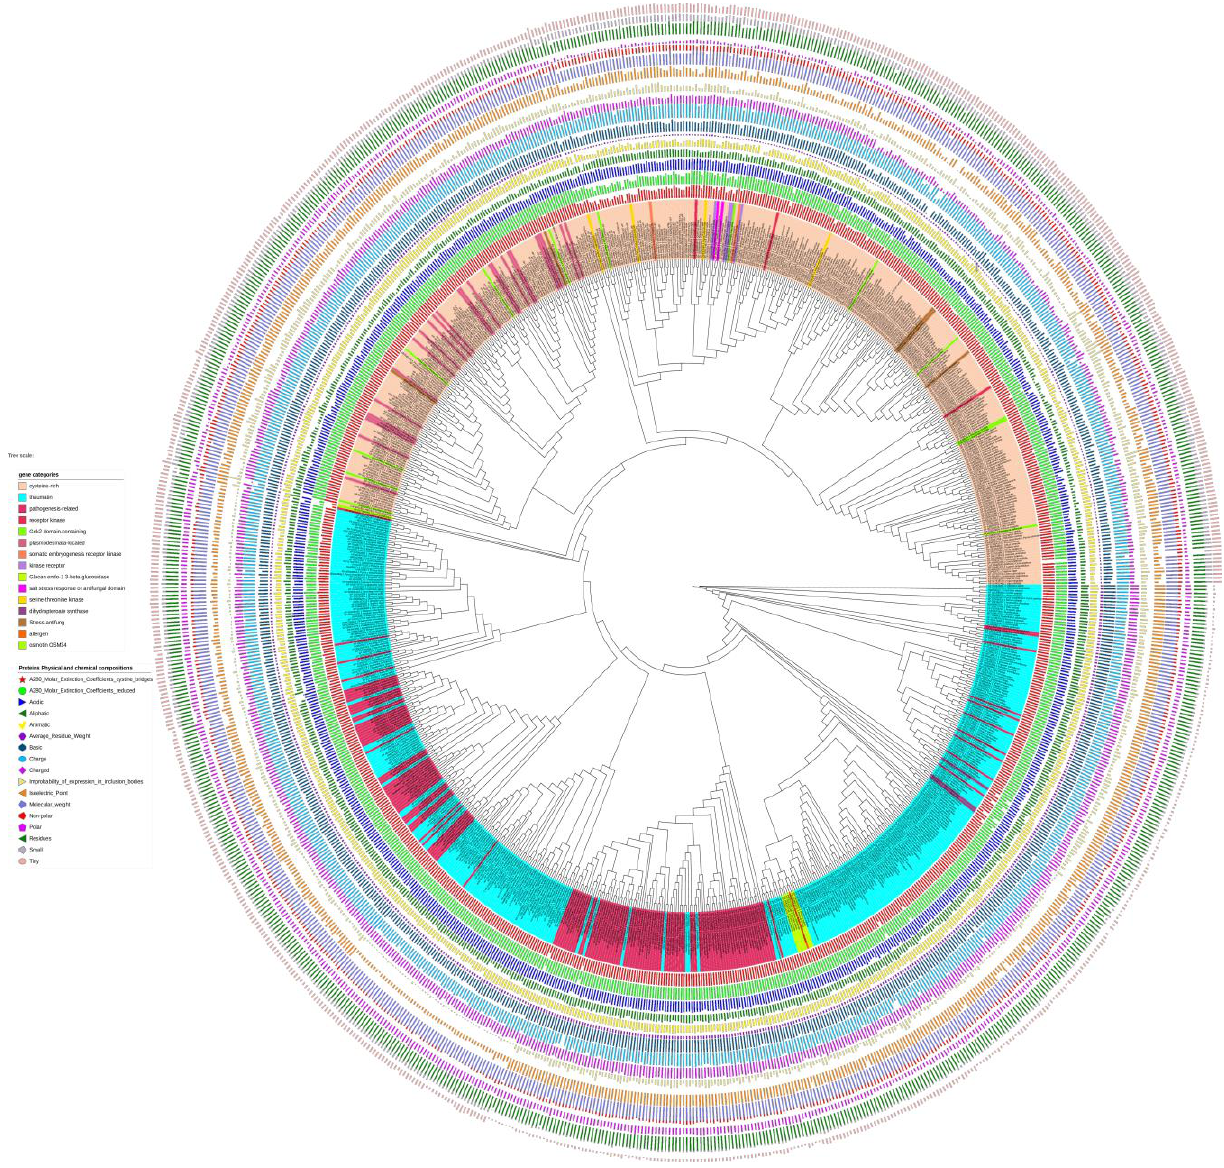
Figure 3 : The phylogenetic tree developed using multiple sequence alignment of chickpea anti-fungal proteins and other species, where its chemical and physical properties are